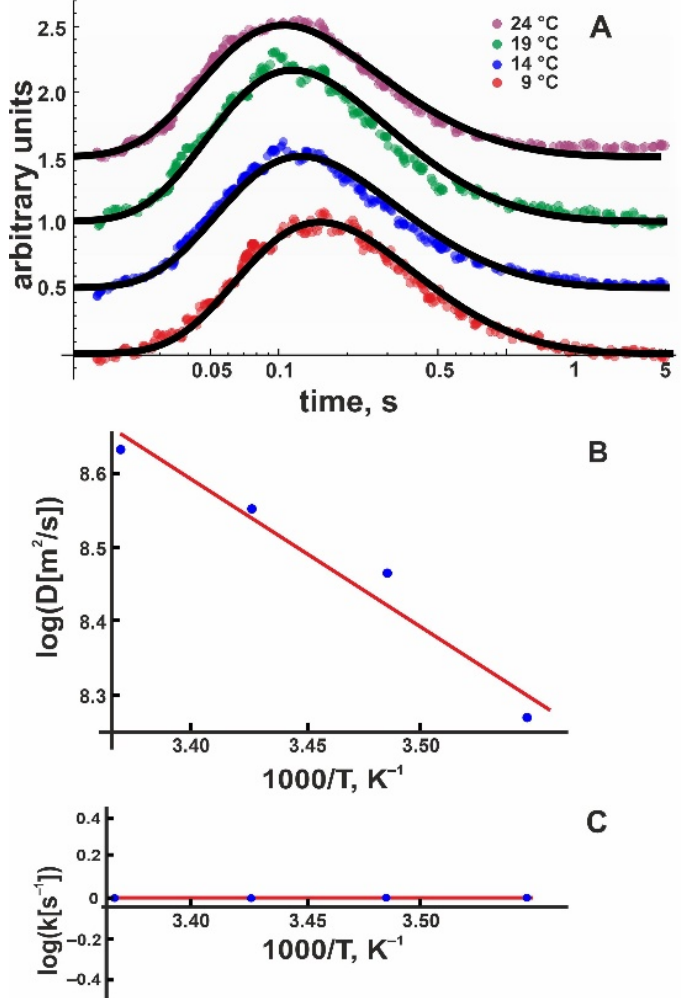
Figure 4. ( A ) Representative time traces of normalized proton concentration changes adjacent to the DOTAP/DOPC membrane surface at the indicated temperatures (colored traces). The distance from the release spot was equal to 50 µ m. The solid black lines represent global fits of the non-equilibrium model (Equation (8)) to all traces at a given temperature. The individual curves were shifted vertically to avoid overlap. ( B ) Temperature dependence of the lateral diffusion coefficient ( D , in units µ m 2 /s). The slope of the temperature dependence corresponds to ∆ H ‡ = 6.6 ± 0.9 k B T . ( C ) The global fit of Equation (8) to the time traces (compare panel A) worked with k off set to (1.2 ± 1.2) s − 1 for all measured temperatures, indicating ∆ H ‡ = 0 ± 3 k B T